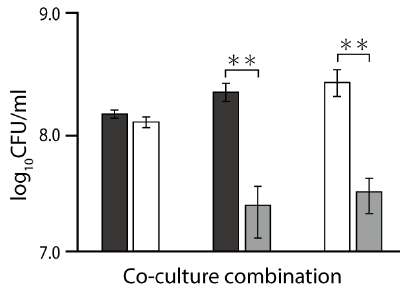
Figure 2. Survival of alaE - and dadA -deficient mutants in the presence of Ala-Ala in a coculture system. Three pairs of MG1655 / MG1655 ∆ dadA , MG1655 / MG1655 ∆ alaE , and MG1655 ∆ dadA / MG1655 ∆ alaE harboring pBR322 or pBR325 were cocultured in minimal medium in the presence of 5 mM Ala-Ala. When cultures reached a mid-log phase, colony-forming units of each strain were determined. Black, white, and grey bars indicate MG1655, MG1655 ∆ dadA , and MG1655 ∆ alaE , respectively. Data presented are the means ± standard deviations from three separate experiments. Asterisks indicate statistically significant di ff erences (unpaired Student t -test, ** <